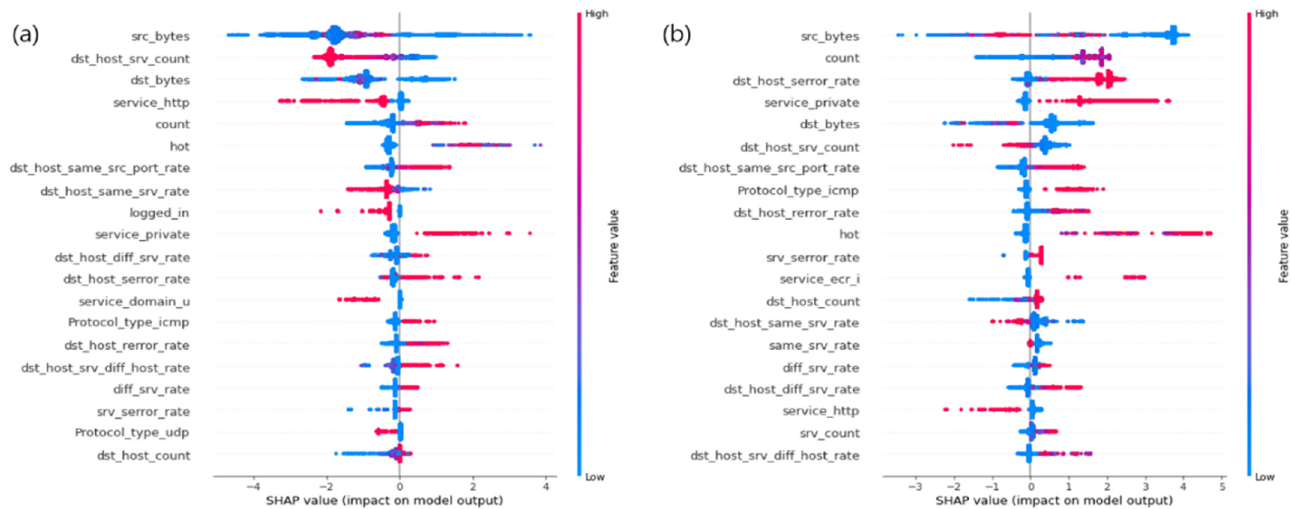
Figure 5. Summary plots by label in training dataset: ( a ) instances labeled normal in the training dataset; ( b ) instances labeled attack in the training dataset.